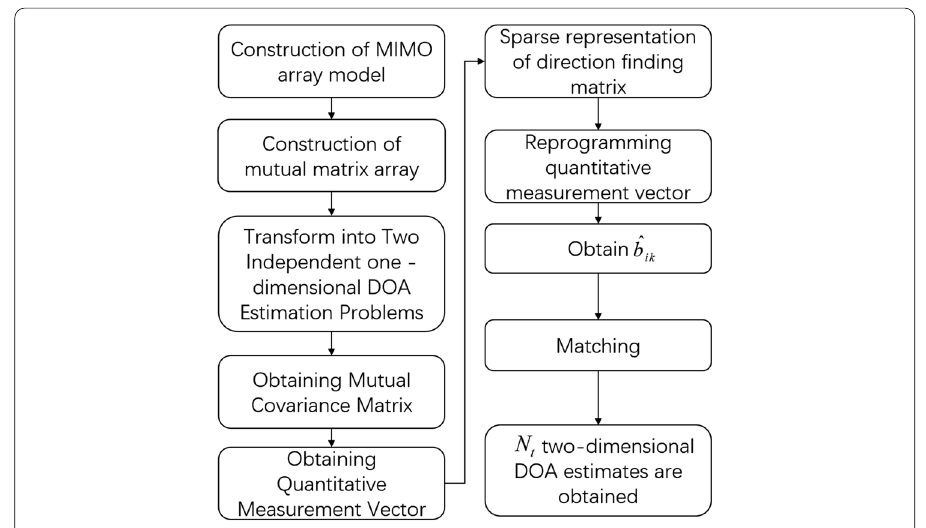
Fig. 5 Steps of the SA-MIMO-CA